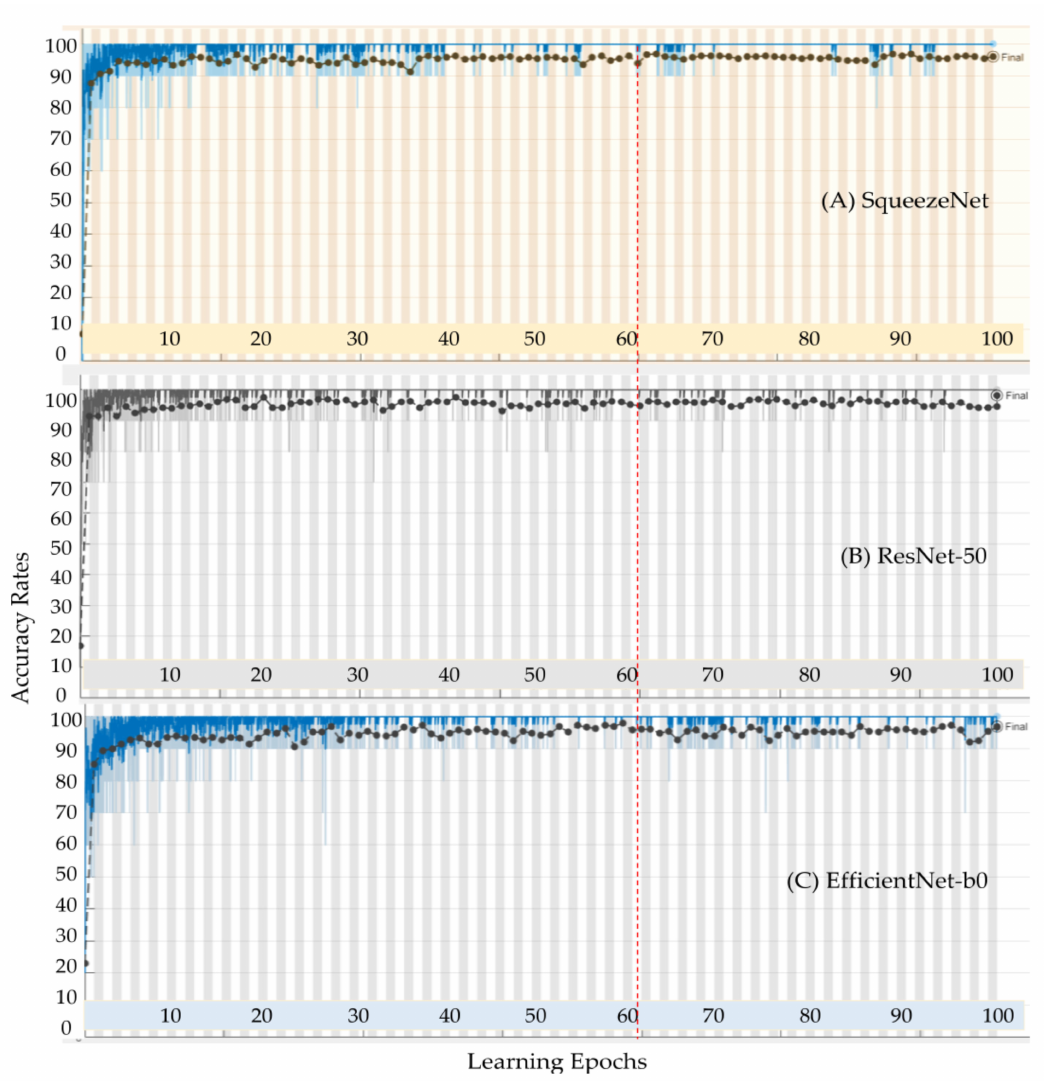
Figure 10. Performance trajectories for models based on ( A ) SqueezeNet CNN, ( B ) ResNet-50 CNN, and ( C ) EfficientNet-b0